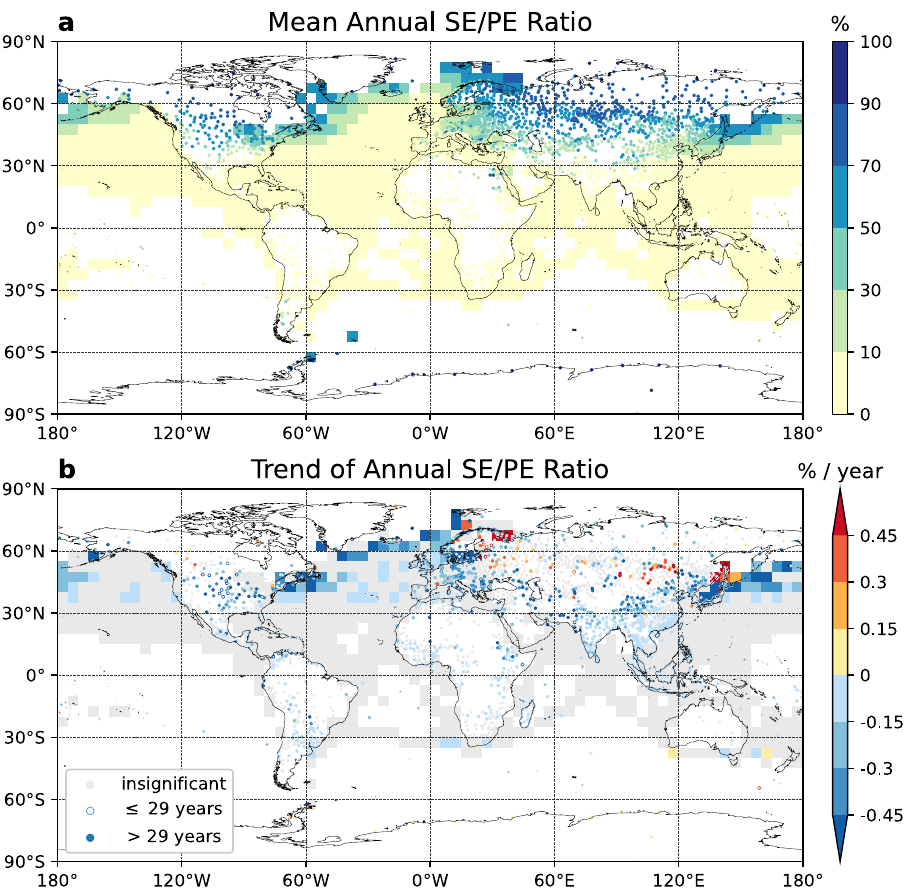
Figure 4. Means and trends of annual snow event to precipitation event ratio. ( a ) Global spatial distribution of mean annual snow event to precipitation event ratio (SE/PE ratio) for 1978–2019. ( b ) Trends (in % year −1 ) of annual SE/PE ratio between 1978 and 2019. Trends were not calculated for the tropical oceans (30° S–30° N). Insignificant trends are shown in gray. Stations with data length between 25 and 29 years are marked as open circles, and those with data length longer than 29 years are marked in filled circles. Stations with less than 25-year qualified data and grids with less than 30-year qualified data for calculating trends are masked out. This figure was plotted using Python 3.7.4 (https:// www. python. org/ downl oads/ relea se/ python-